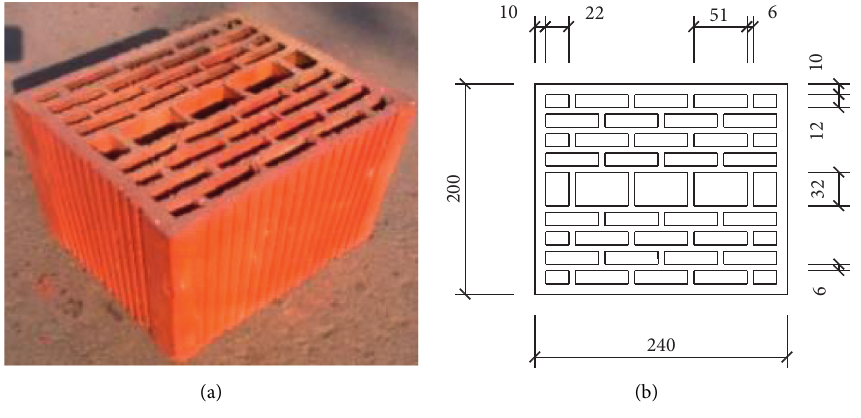
Figure 1: Dimensions of fired shale hollow block. Table 1: Composition of